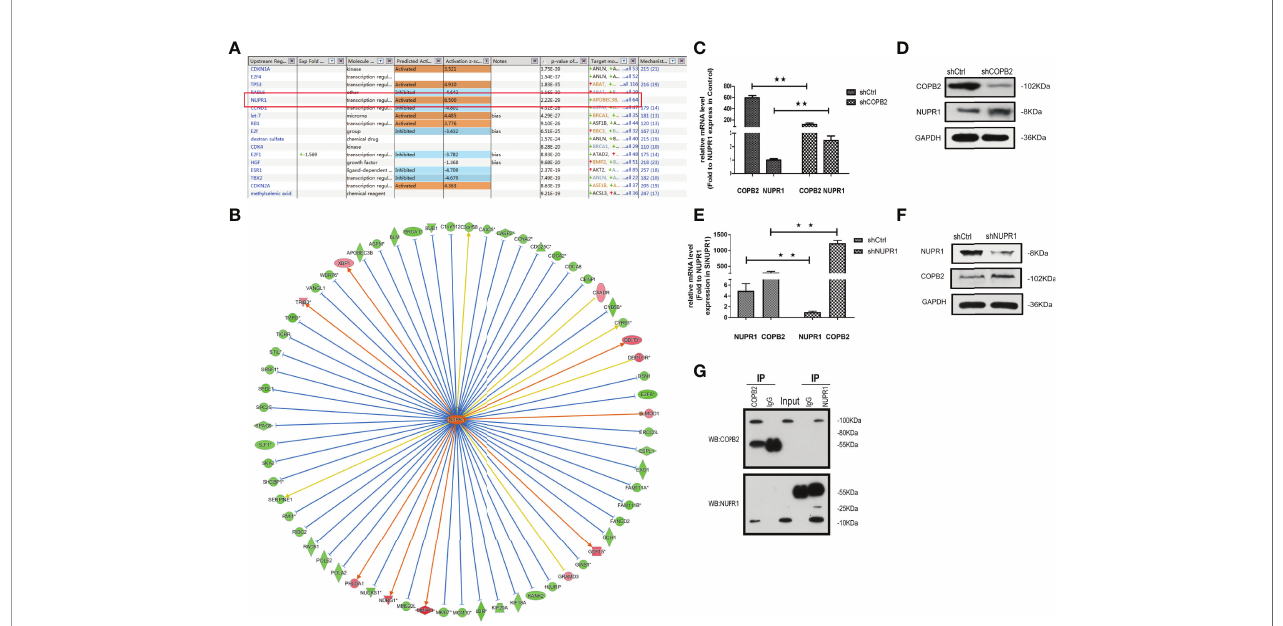
FIGURE 8 | NUPR1 is the interaction protein in the downstream of COPB2 . (A) The most different downstream regulators after COPB2 was downregulated, in which NUPR1 was the most activated ( Z -score = 6.500), ESR1 was the most inhibited ( Z -score = -4.709). (B) The interaction between NUPR1 and its downstream regulators by IPA analysis. Orange line between the upstream regulator and gene expression of consistent activation state, the blue line shows the upstream consistent inhibition between regulators and gene expression of the state, and the yellow line shows the upstream regulator between gene expression of the state, gray line shows the state related data set does not exist and the expression of forecasting information. (C, D) The mRNA and protein expression of NUPR1 after COPB2 knockdown via qRT-PCR and western blot. (E, F) The mRNA and protein expression of COPB2 after NUPR1 knockdown via qRT-PCR and western blot.